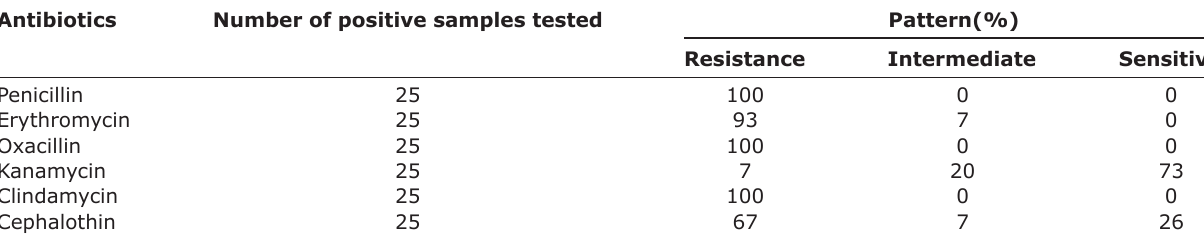
Table-3: Antimicrobial resistance pattern of Salmonella isolates from Asian pied starling. Antibiotics